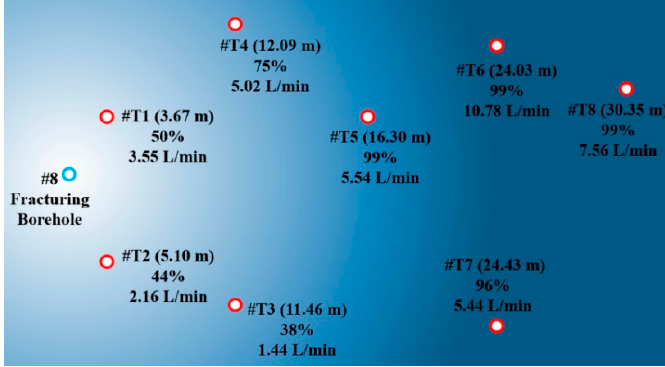
Figure 10. Schematic diagram of methane enrichment circle. Figure 11. Location relationship between test boreholes and the #8 fracturing borehole.